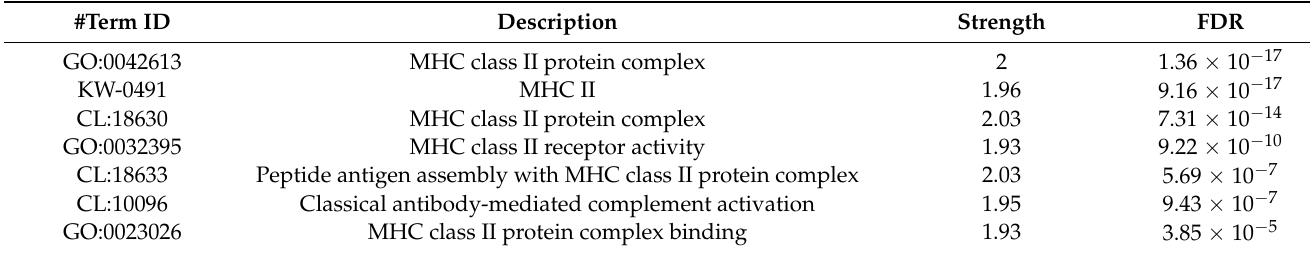
Table 2. Hub gene enrichment analysis by STRING